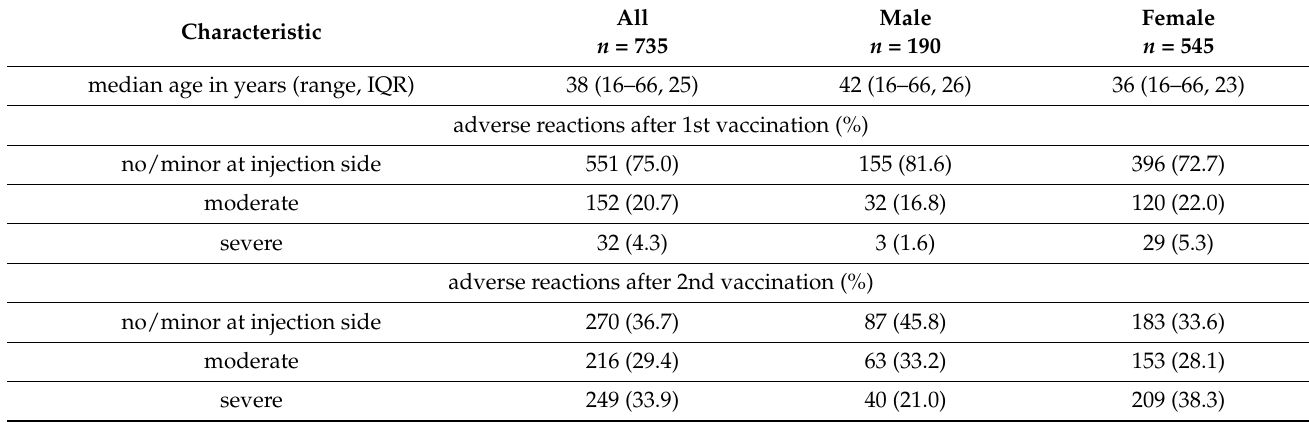
Table 1. Adverse reactions after BNT162b2 vaccination in the recruitment population. IQR = interquartile range.